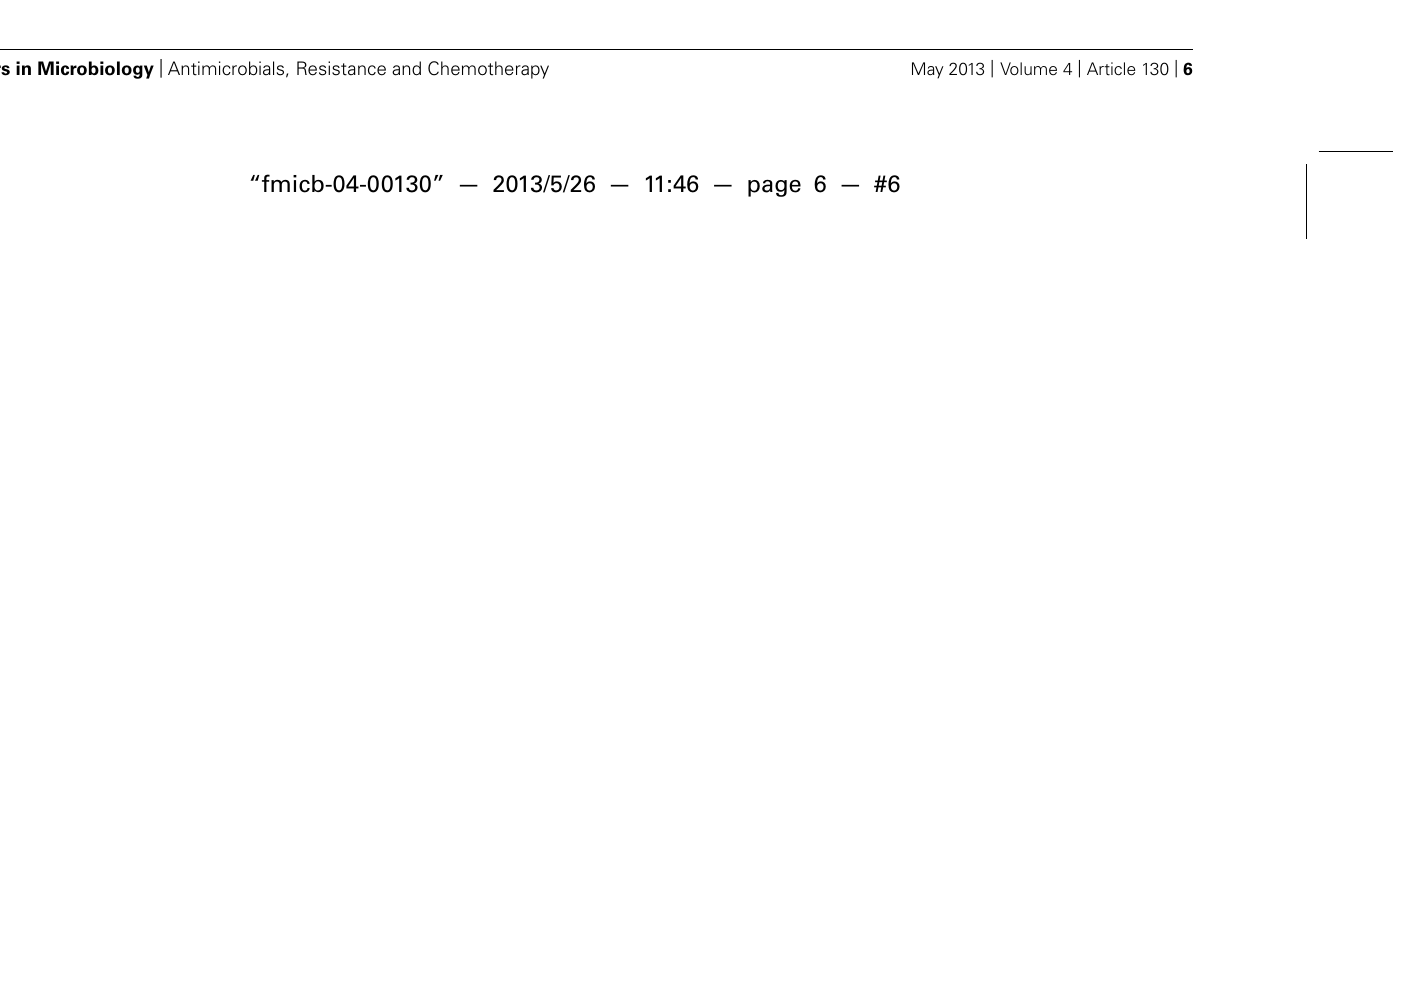
Frontiers in Microbiology | Antimicrobials, Resistance and